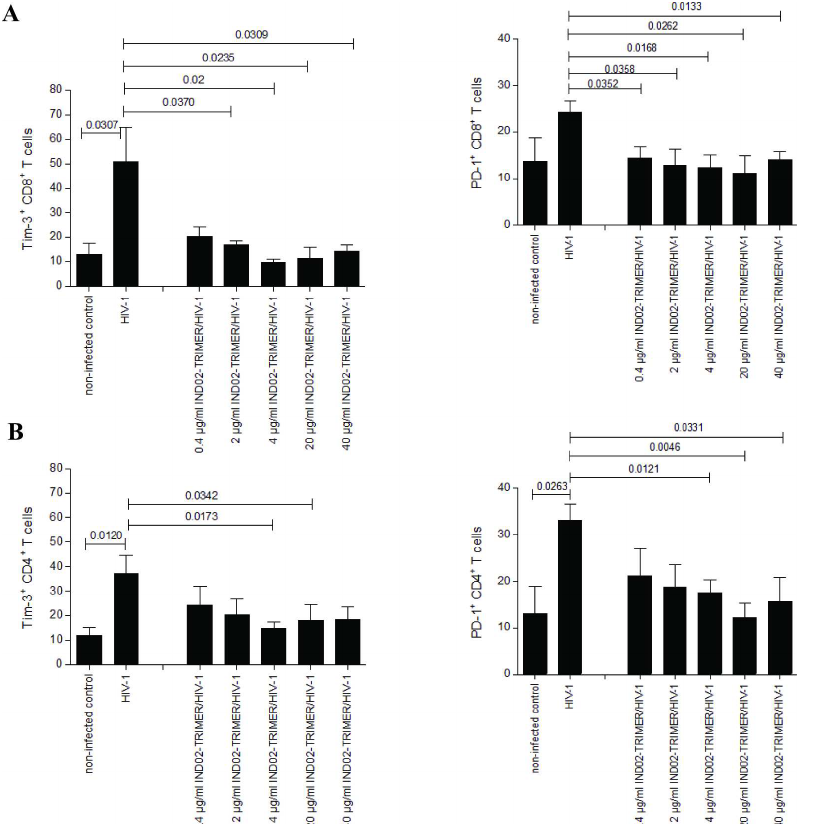
Fig 5. Reduction of Tim-3 (left) and PD1 (right) expression on HIV-1 and IND02-trimer-treated CD8 + (A) and CD4 + (B) T cells. StimulatedPBMCs were simultaneously incubatedwith 0.4 to 40 μ g/ml (0.46– 46.3 μ M) IND02-trimer and HIV-1 (92UG037, BaL, YU2b, 93BR020 or NL4-3). Up-regulation of Tim-3 (left) and PD-1 (right) on CD8 + (A) and CD4 + (B) T cells was impededby the IND02-trimer, as shown by multicolour FACS analysesof live T cells on day 9 post co-treatment. Experiments were repeated in 4–5 independent experiments with cells from different donors and statistical differences were analyzedby the GraphPad prism software using the unpairedstudent’s t-test